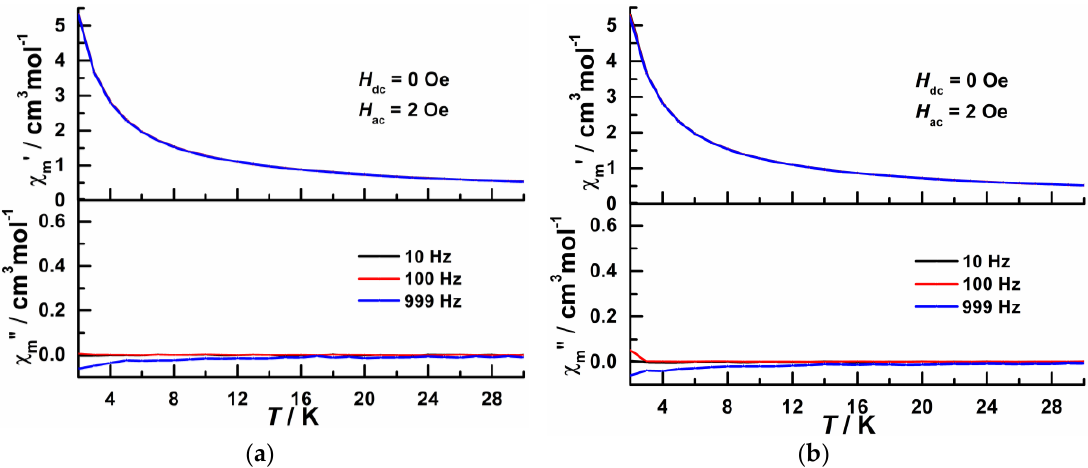
Figure 3. Temperature dependence of the in-phase ( χ ′) and out-of-phase ( χ ″) ac susceptibilities under a 0 Oe dc field for ( a ) 2 and ( b ) 3 .